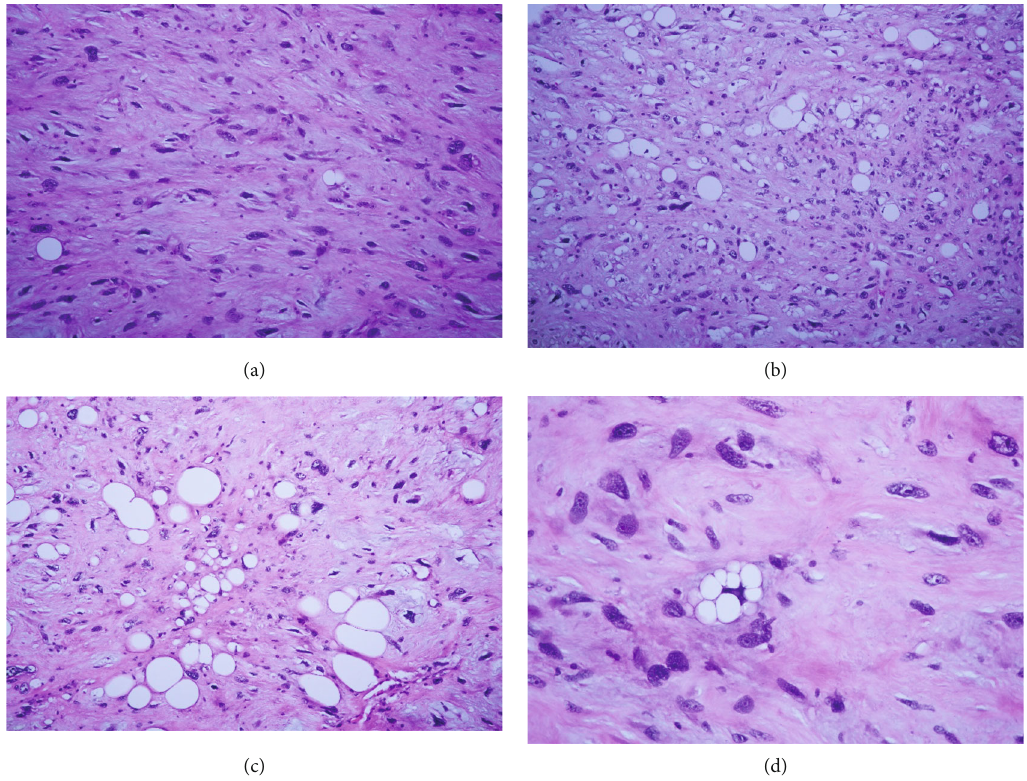
Figure 6: Pathological diagnosis of tissue from right proximal femur: metastatic pleomorphic liposarcoma, with the presence of vascular invasion and all surgical resected margins appear free of tumor. 20 × (a, b), 40 × (c), and 60 × (d).